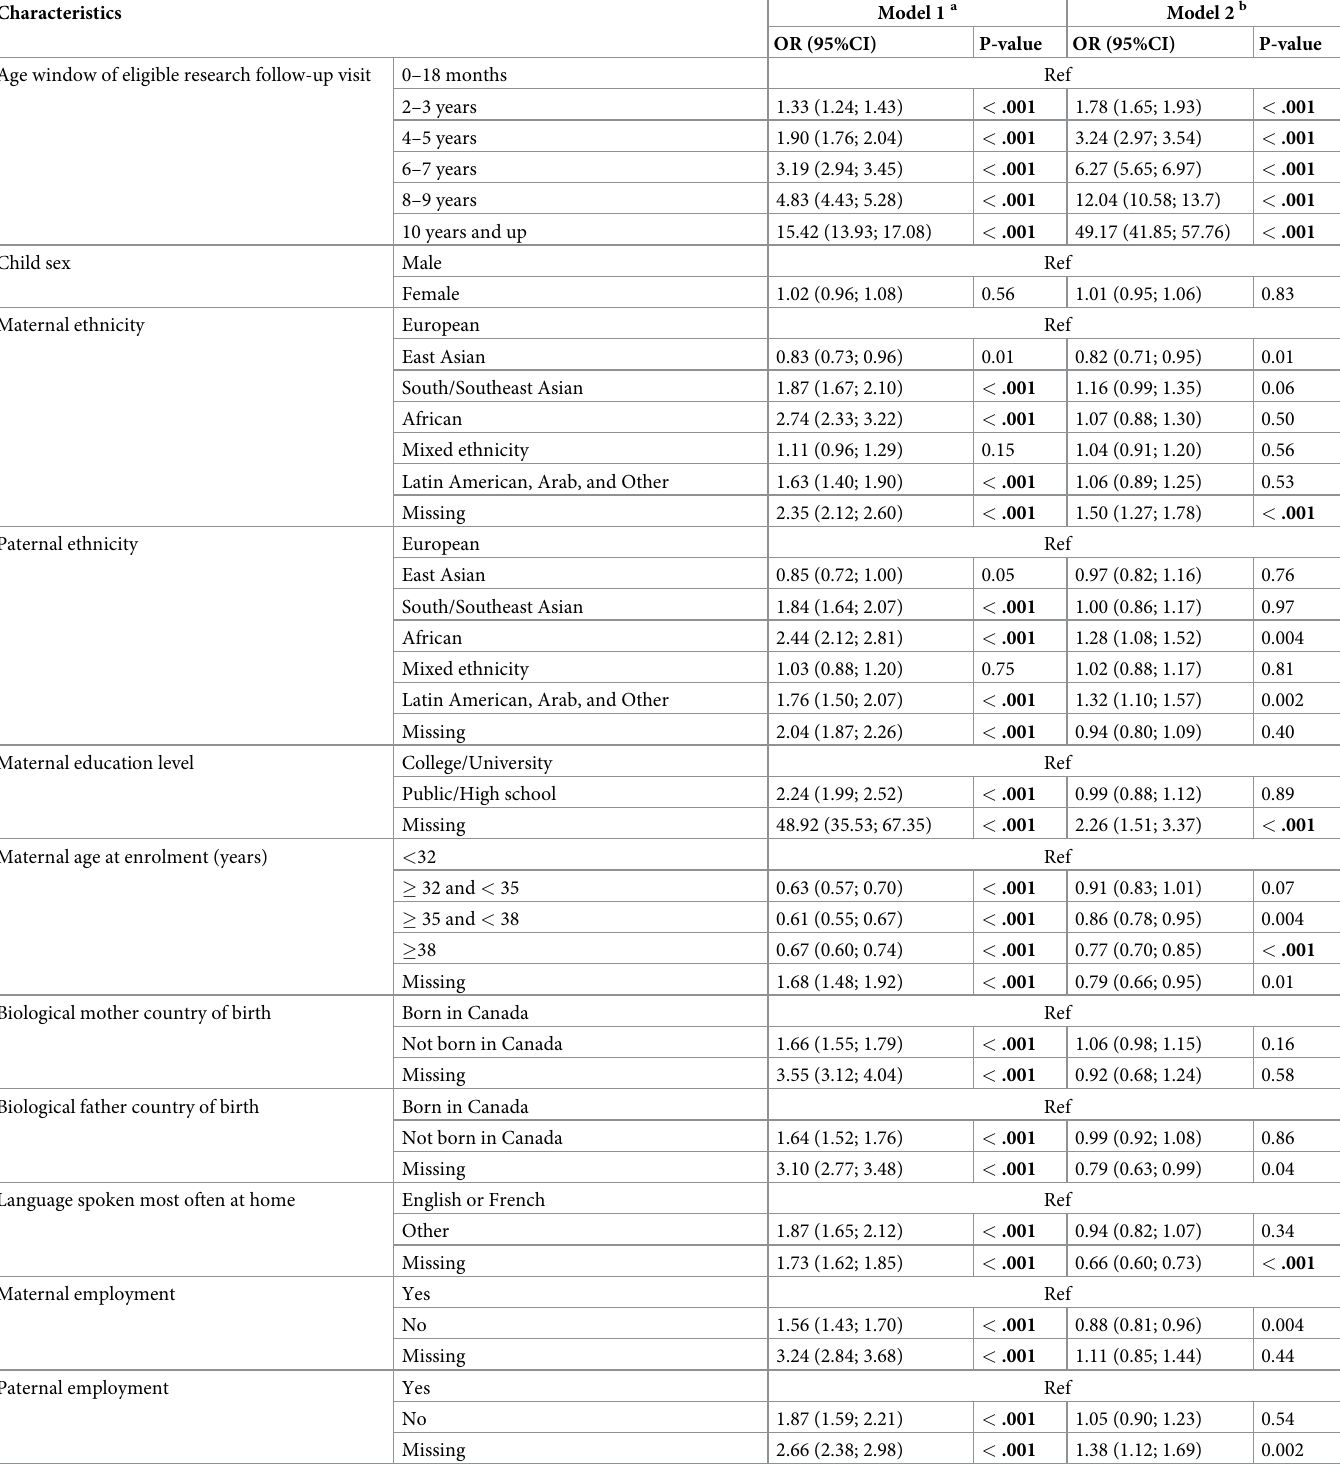
Table 4. Factors associated with missed research follow-up visits (10,412 subjects, 62,655 eligible follow-up visits).